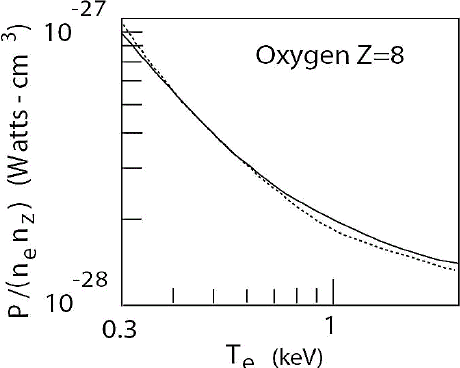
Fig. 3. Total radiation power as a function of electron energy for oxygen, from Jensen et al.